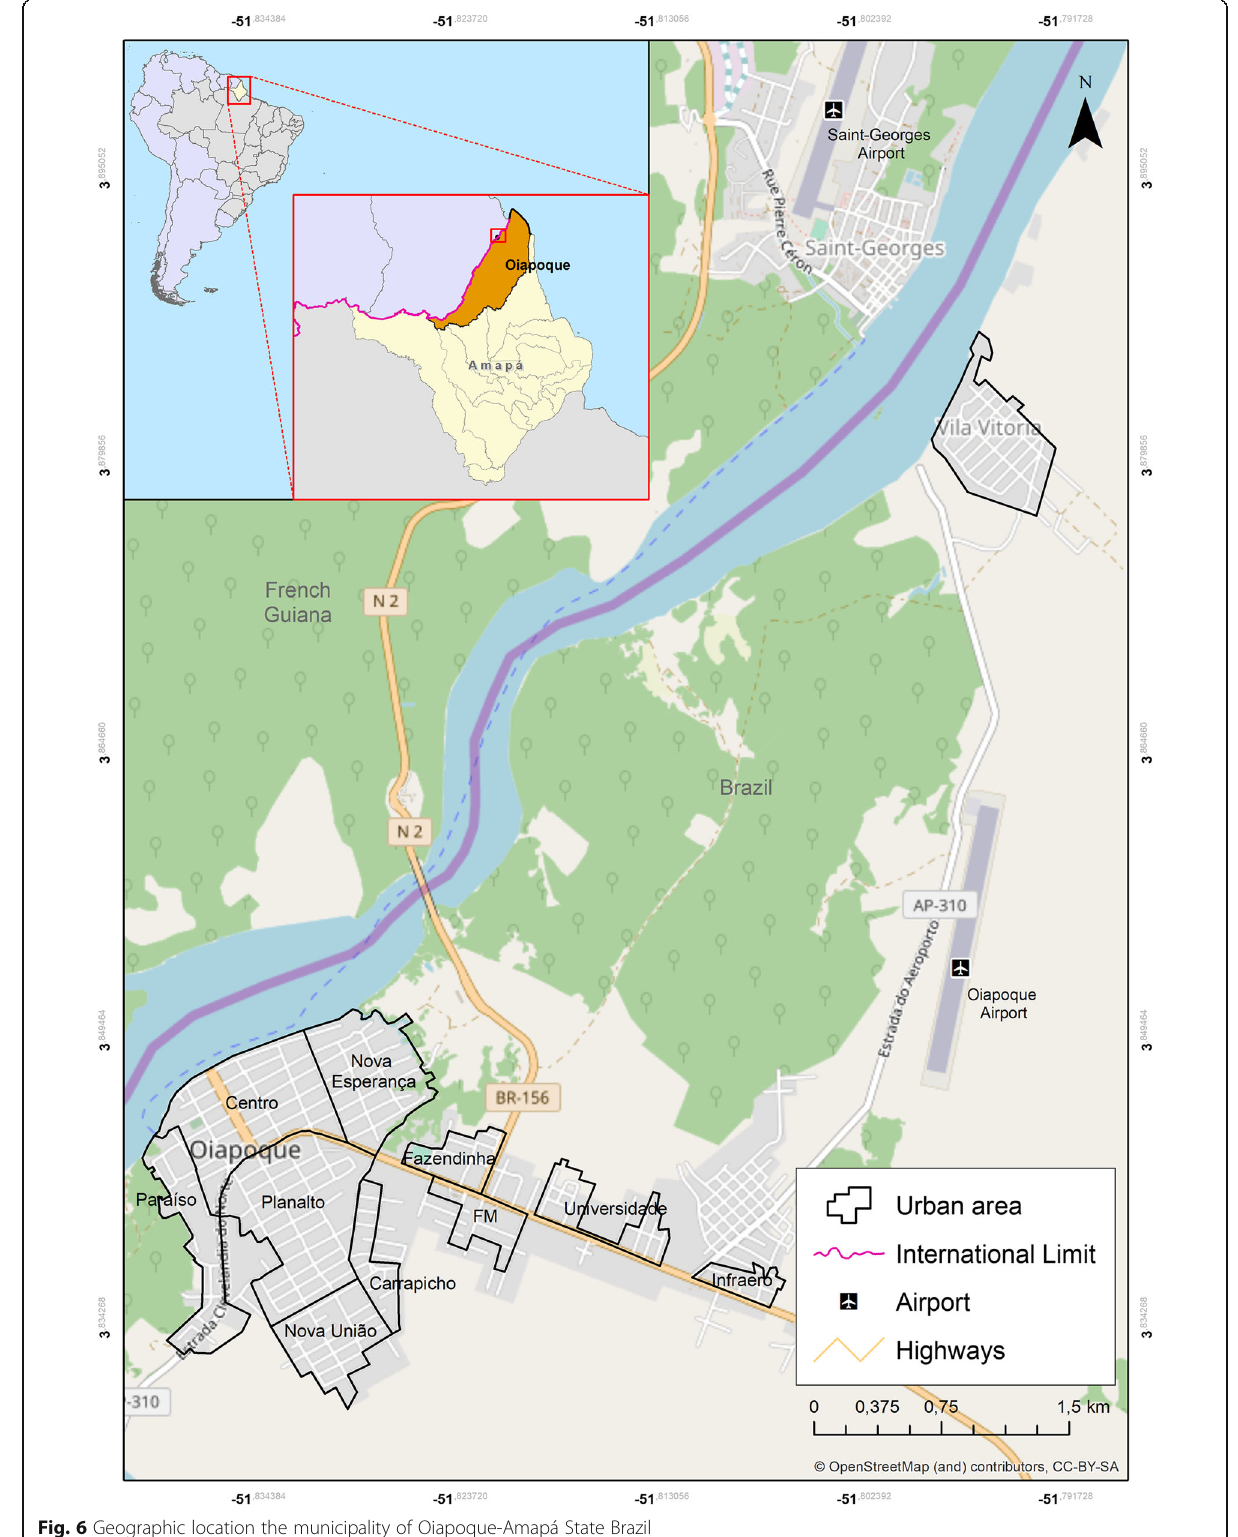
Fig. 6 Geographic location the municipality of Oiapoque-Amapá State